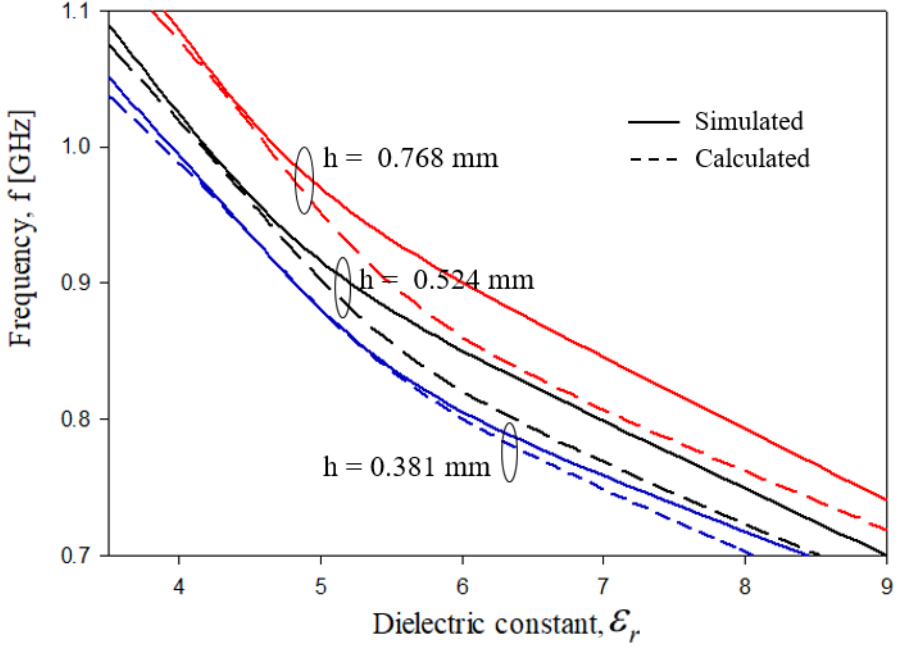
Figure 4. Validation of design equation for CSR. Table 1. Analysis of CSR for RFID